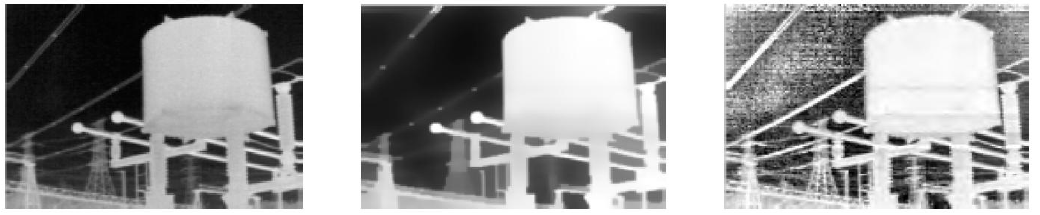
Fig. 2. The results of component estimation with proposed